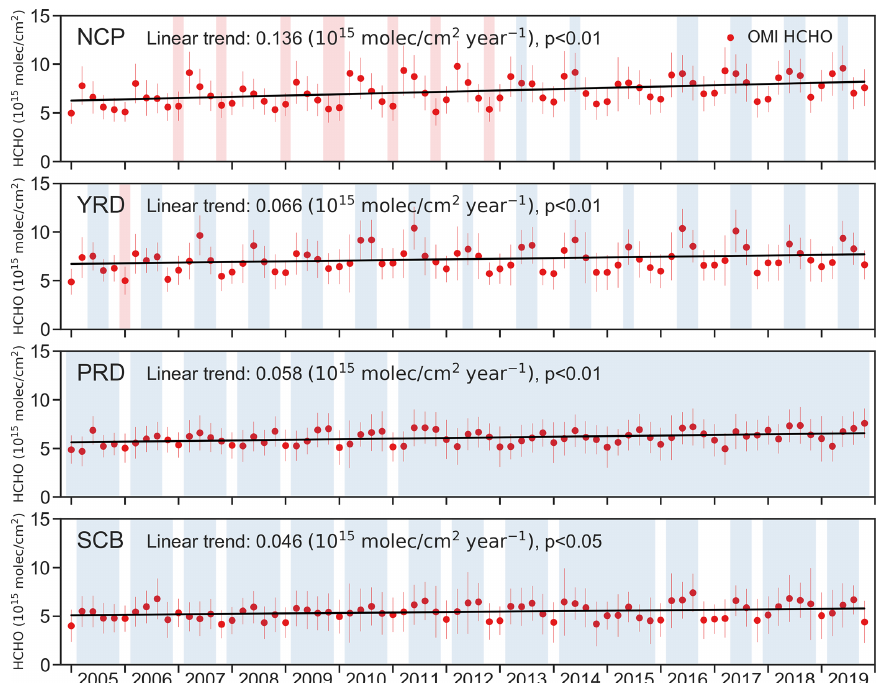
Figure 6. The time series of HCHO columns in the four megacity clusters from 2005 to 2019. Black lines indicate the linear trend of HCHO columns. Red, white, and blue areas stand for VOC-limited, transitional, and NO x -limited regimes, respectively.